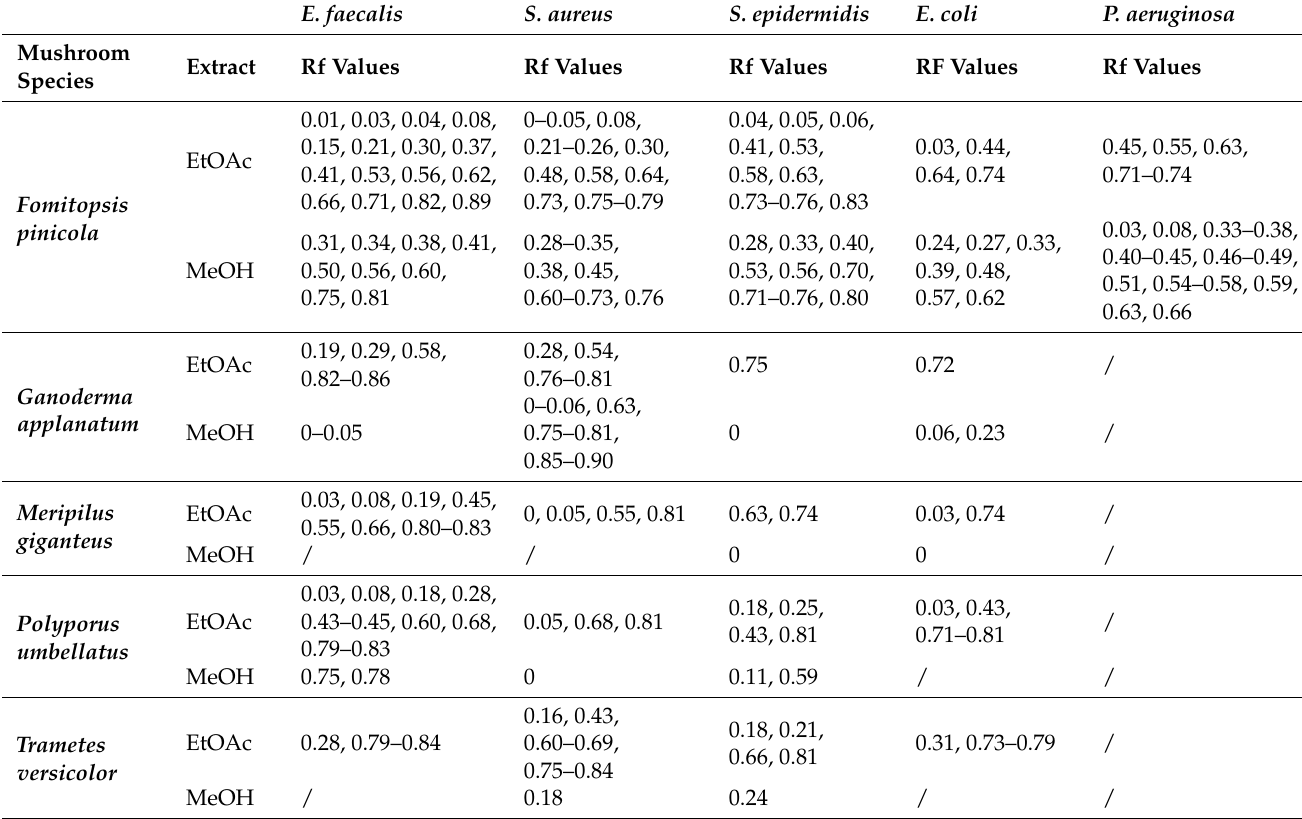
Table A6. Antibacterial activity induced by Polyporales mushrooms against wild-type bacteria expressed as Rf values of inhibition bands.